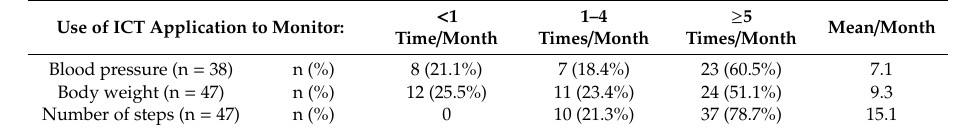
Table 2. Use of ICT app by ICT group.